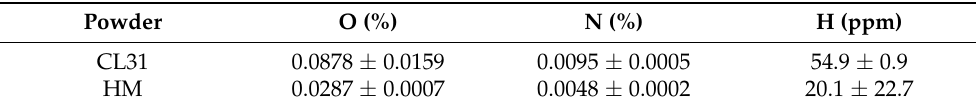
Table 5. Results of the ONH analysis of the